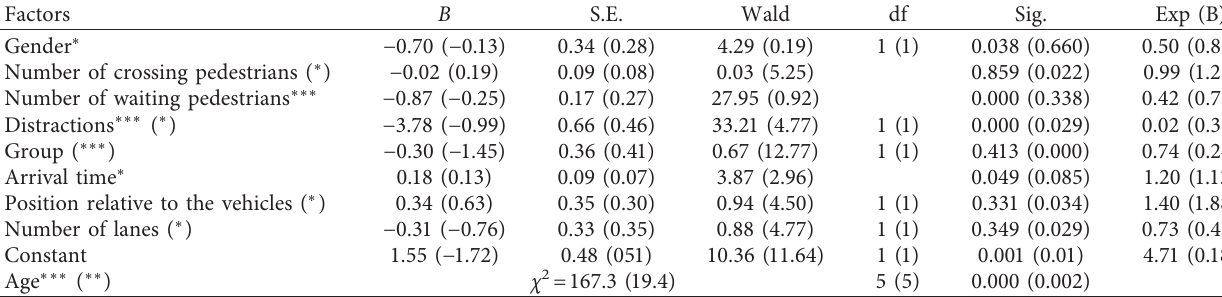
Table 4: Predictors of pedestrians’ choices estimated by binary logistic model and the chi-square test.